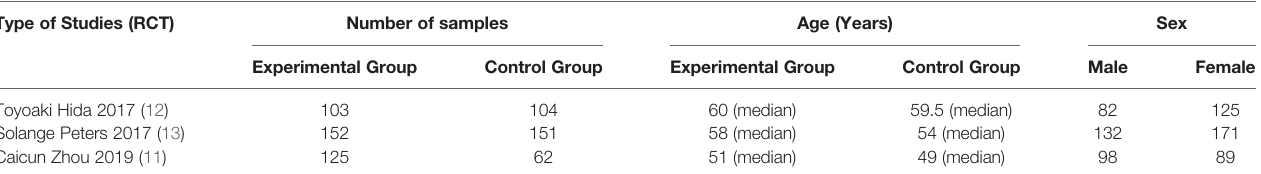
TABLE 2 | Basic characteristics of included studies.